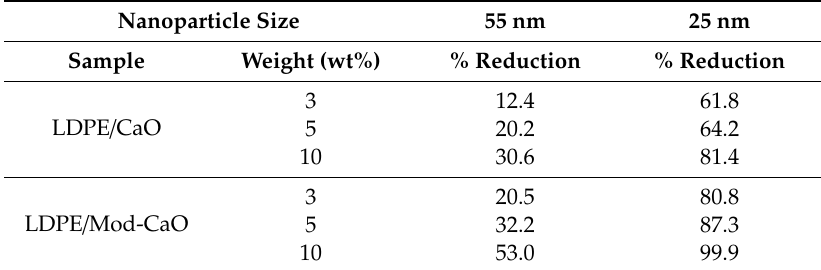
Figure 8. Stress–strain curves of LDPE, LDPE/CaO, and LDPE/Mod-CaO with CaO nanoparticles ca. 25 nm. Table 3. Percentage reduction in E. coli bacteria for CaO / LDPE nanocomposites using CaO of ca. 55 nm or 25 nm